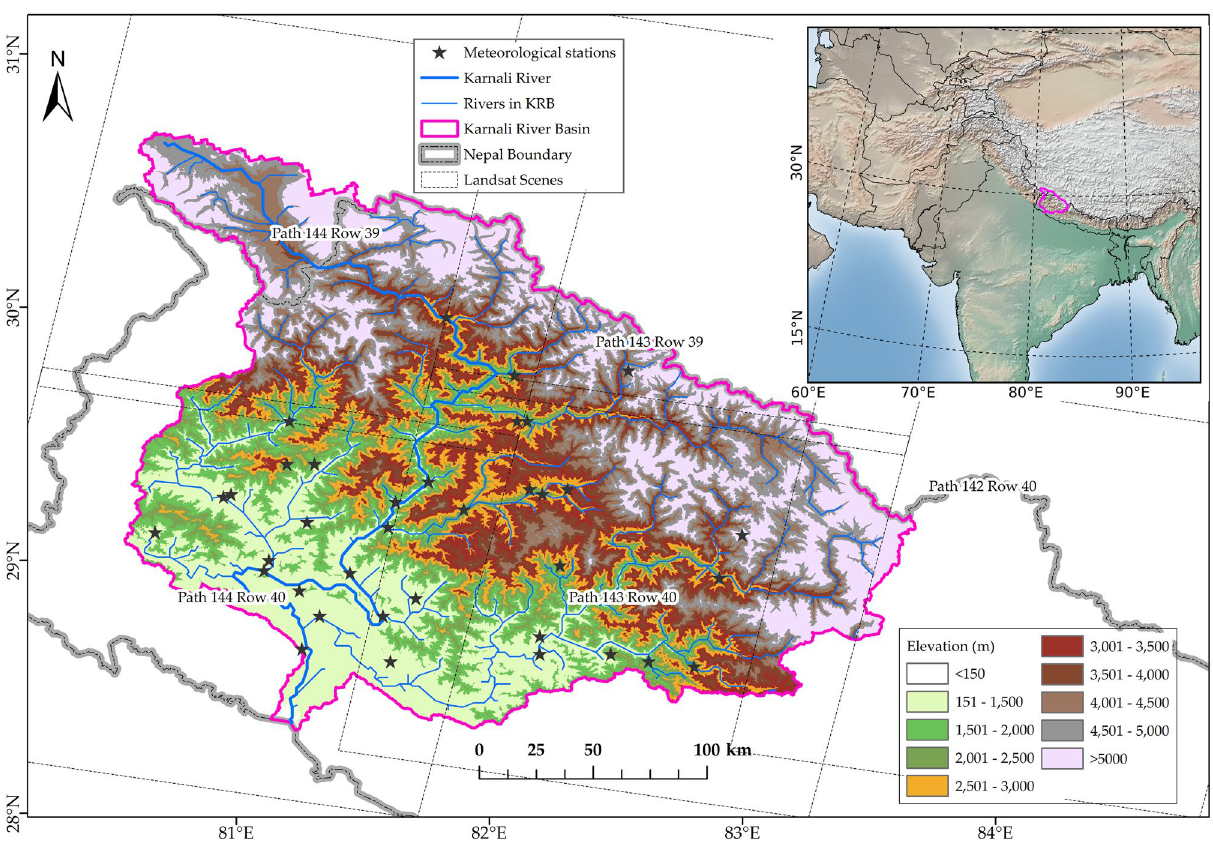
Fig. 1 Karnali River Basin with meteorological stations